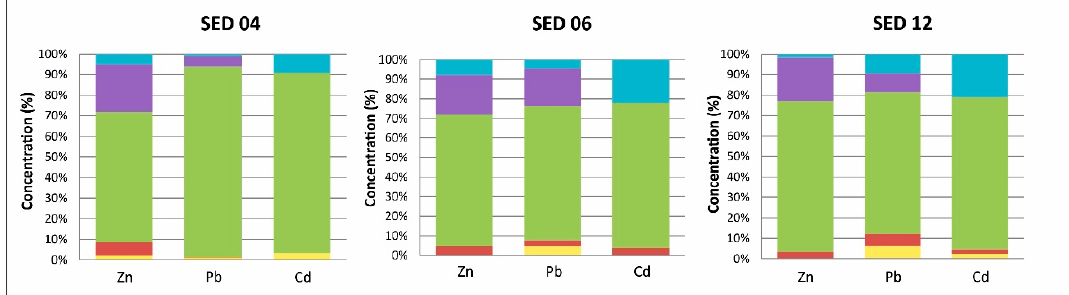
Figure 4. Proportions of the fractions upon sequential extraction of the sediment samples. SED—sediment sample.